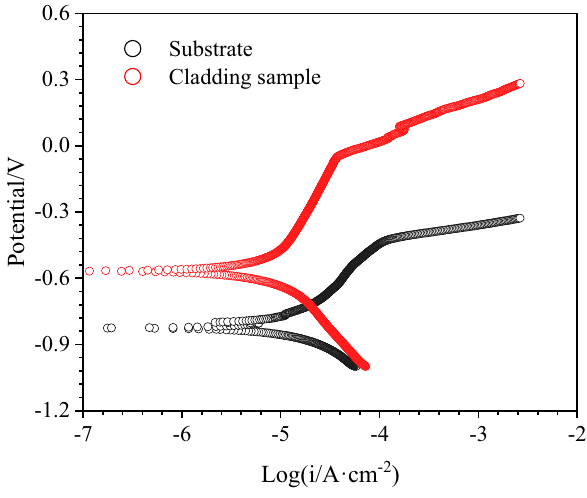
Figure 7: Polarization curves of SUB 27SiMn steeland cladding